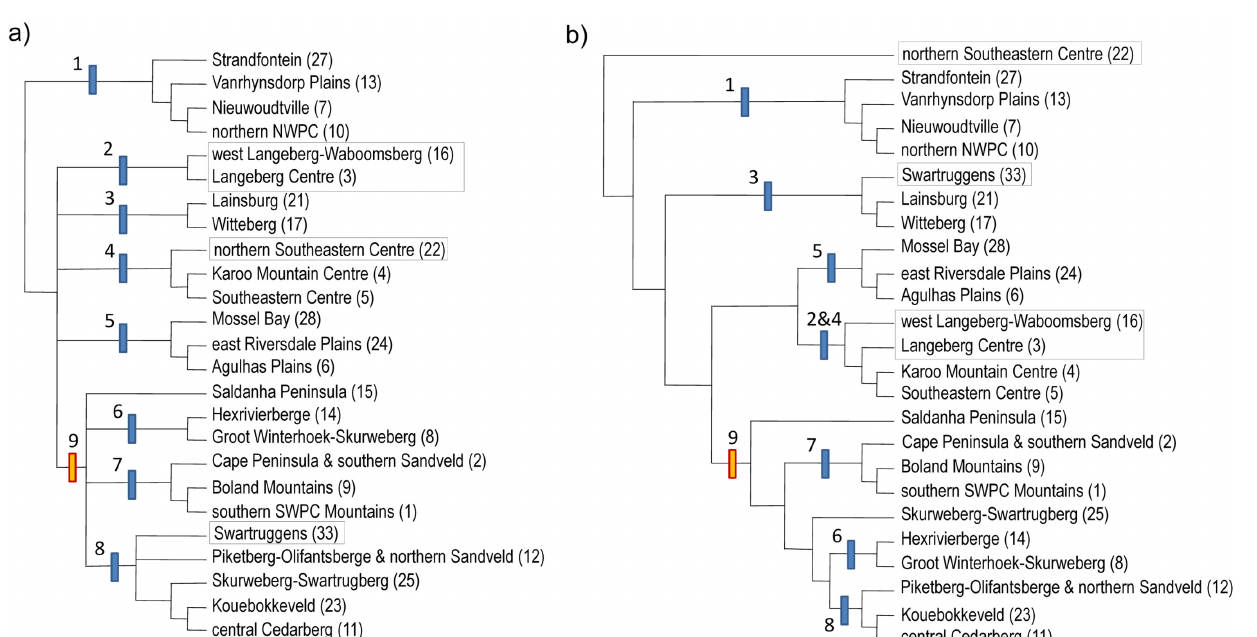
Fig 9. Consensus hierarchical clustering of core CFR CoE OGUs. Hierarchy clustering used Kulczinsky2 similarity (a) left pane) and Jaccard (b) right pane) each on the three weightings used in this study (Bell, Inverse and Integrated). BR numbers refer to: northern Northwest BR (1), Langeberg BR (2), Witteberg BR (3), East BR (4), Agulhas Plains BR (5), southern Northwest BR (6), Southwest BR (7), central Northwest BR (8), western CFR cluster (9). CoE whose positions differ between dendrograms are boxed. The results of Kulczinsky2 (5a) were used to delimit BRs in Fig 6.